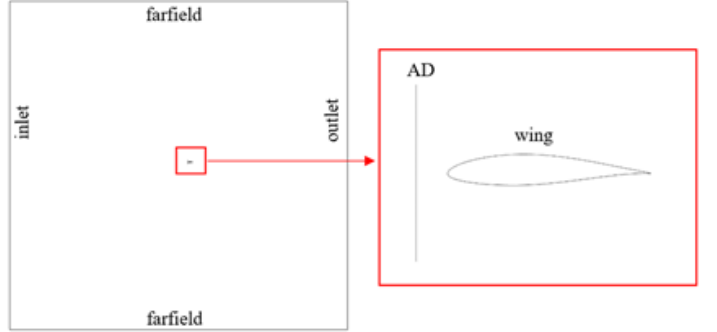
Figure 12. Computational domain. Side cross section.